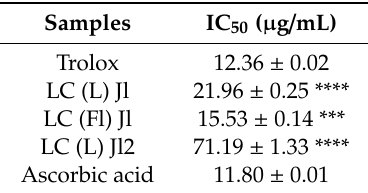
Table 6. IC 50 values of antioxidant activity of L. camara essential oil by 2,2-diphenyl-1-picrylhydrazyl (DPPH) assay. Data are expressed as the mean of triplicates.